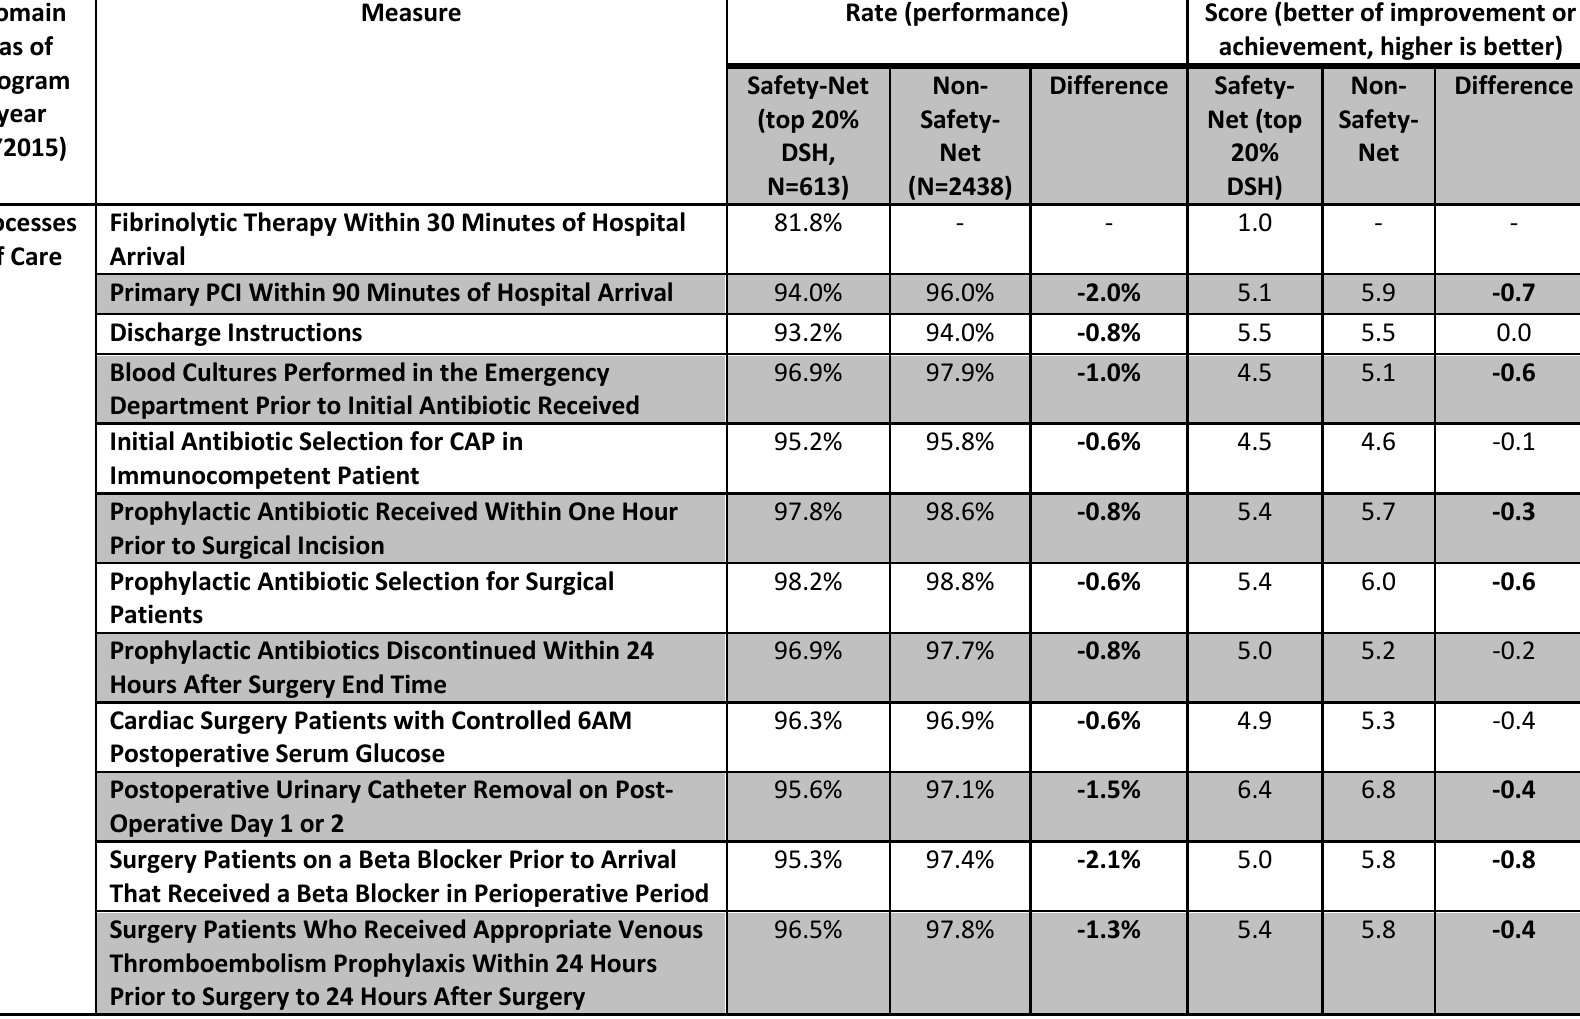
Table 7.8 (continued): FY2015 Measure Rates and Scores, by Hospital Safety-Net (top 20% DSH) Status